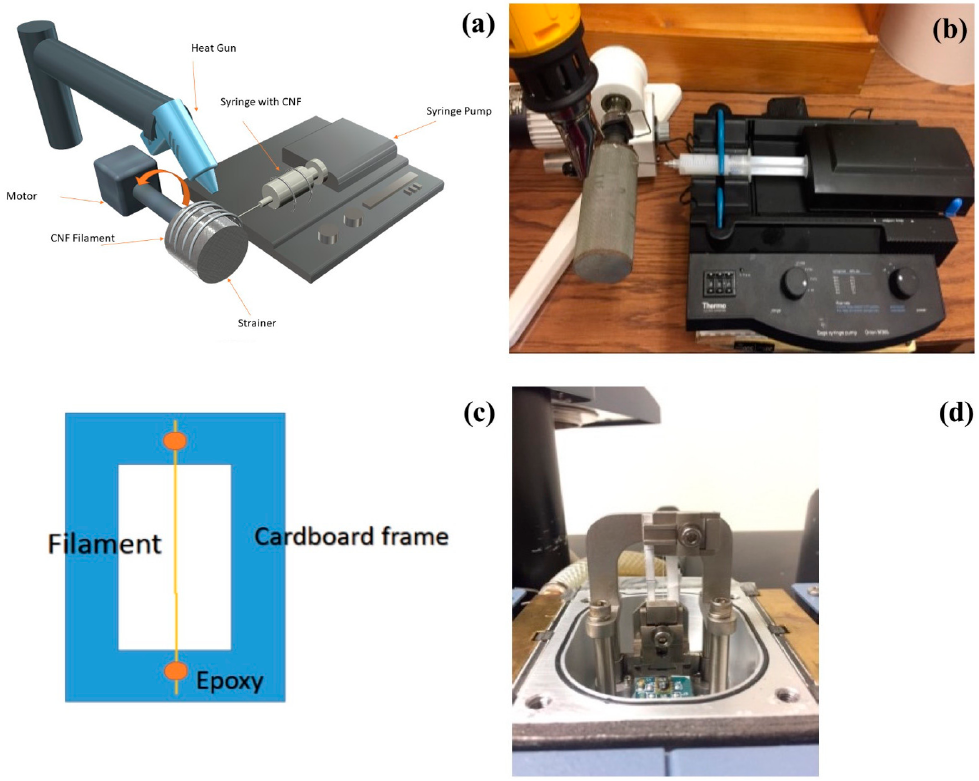
Figure 1. Filament spinning method and tensile testing ( a ) schematic representation of the spinning assembly; ( b ) photo of spinning assembly and heat gun; ( c ) schematic presentation of the